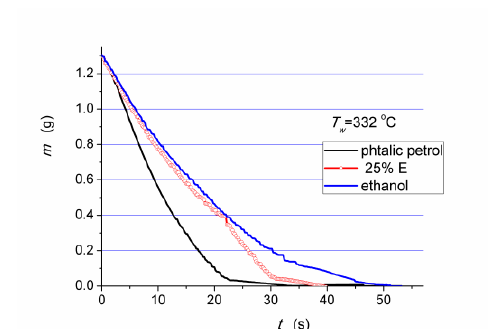
Fig. 7. Evaporation of droplets of ethanol, petrol and its mixture with